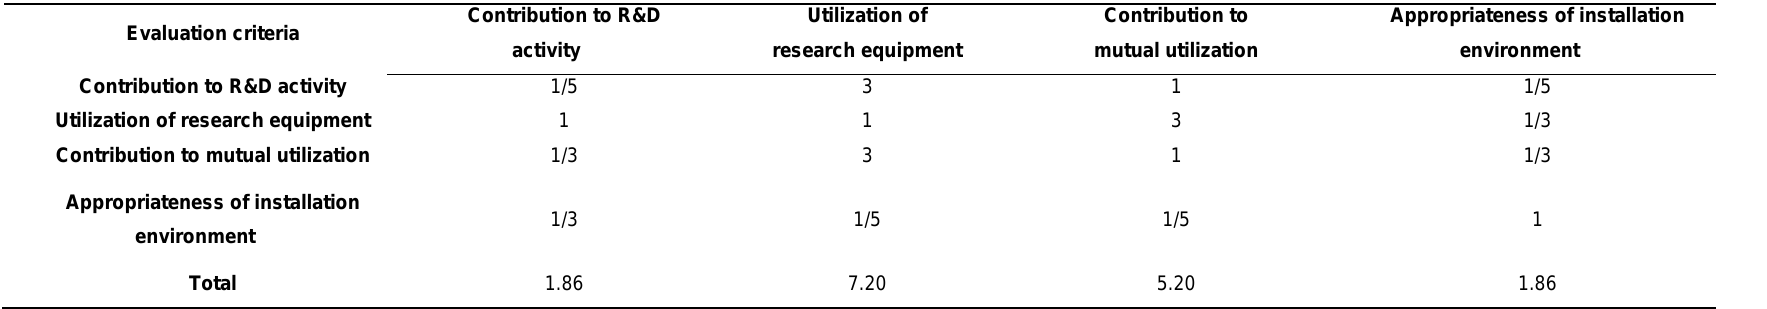
Table 11. Relative importance total of the evaluation criteria